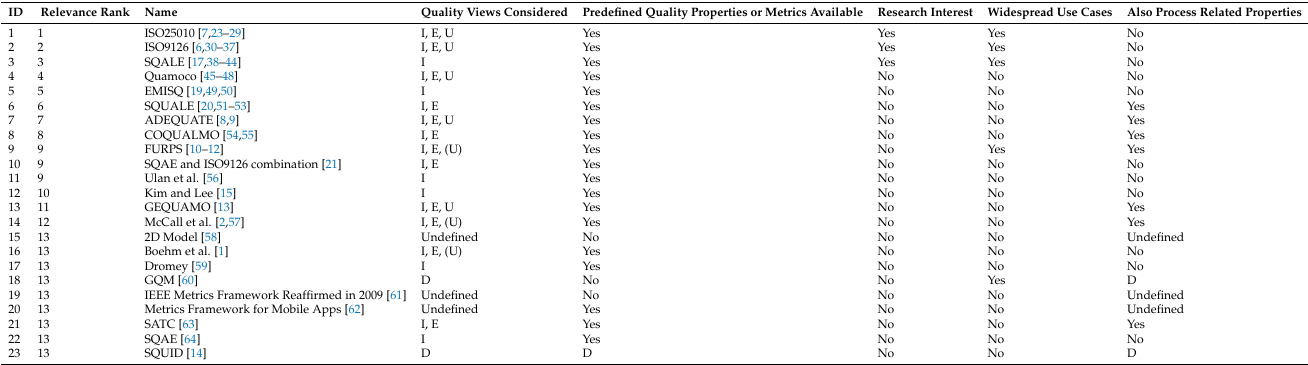
Table 2. Taxonomy: software product quality model families and their quality